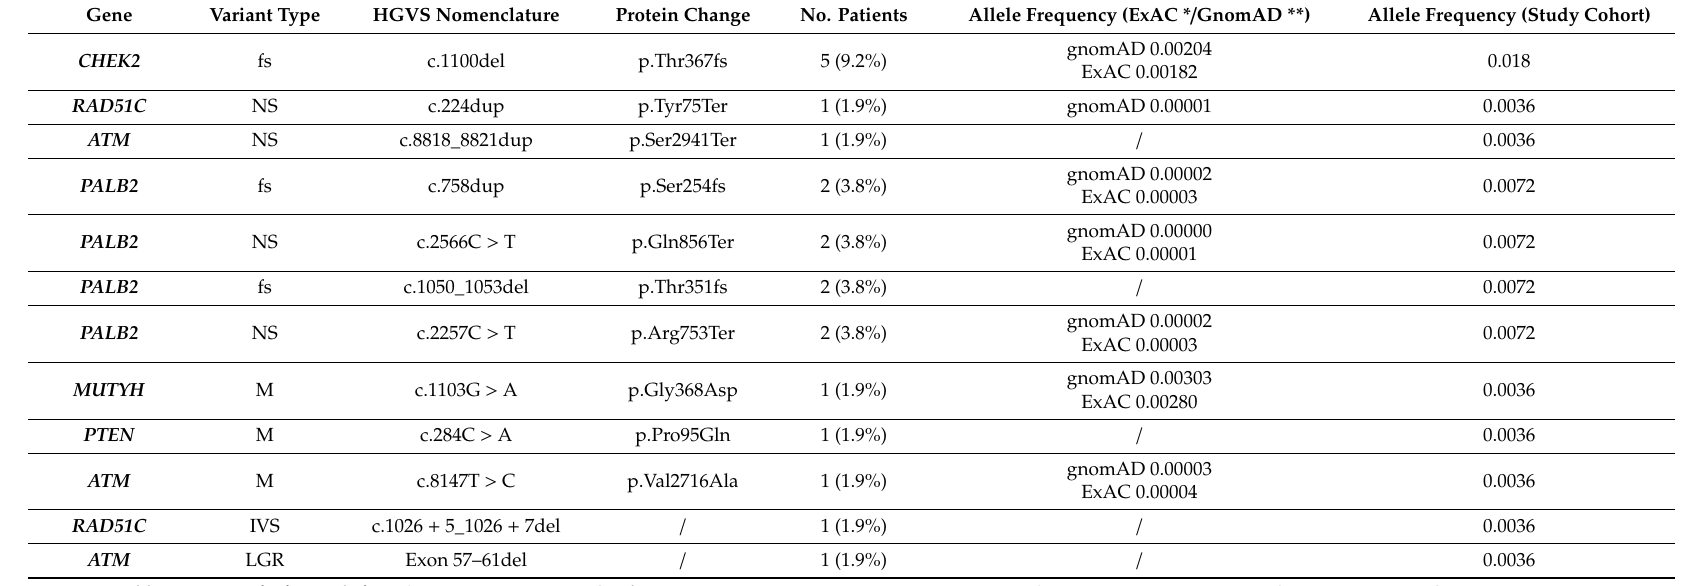
Table 3. Pathogenic variants detected in no- BRCA genes of patients with bilateral breast cancers positively tested by multi-gene panel.